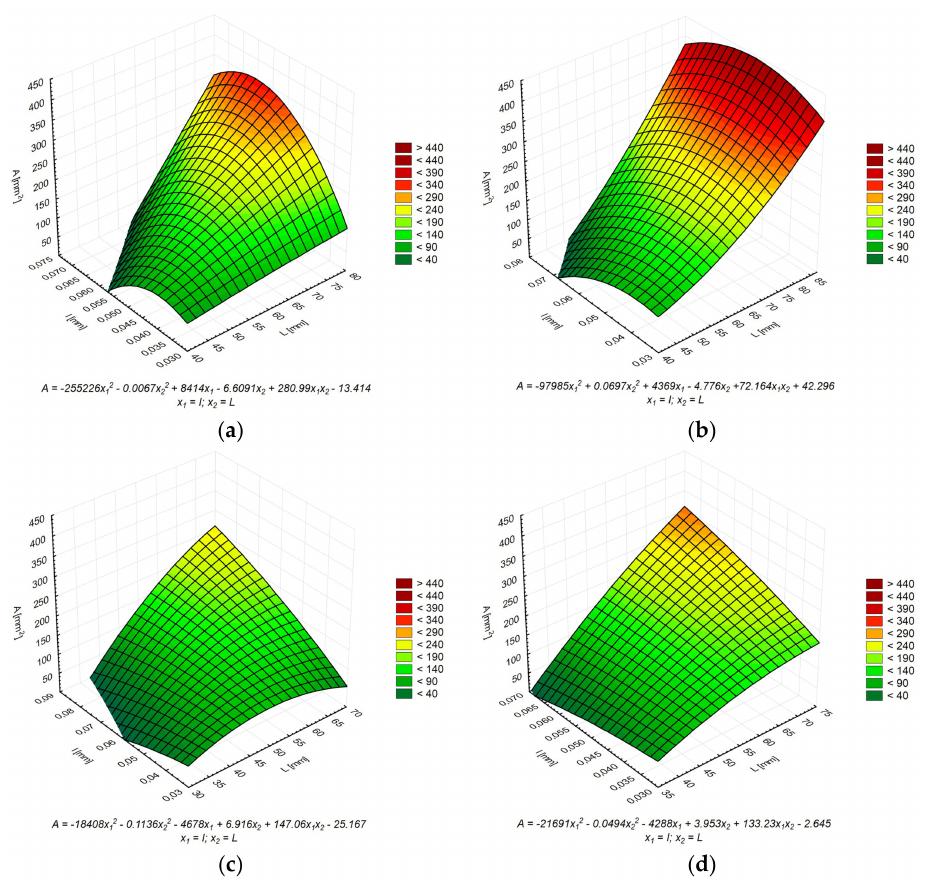
Figure 9. The dependence of the average cluster area A on the other stereological parameters ( L and I ) for each series: ( a ) C42; ( b ) C42MT; ( c ) C52; ( d )